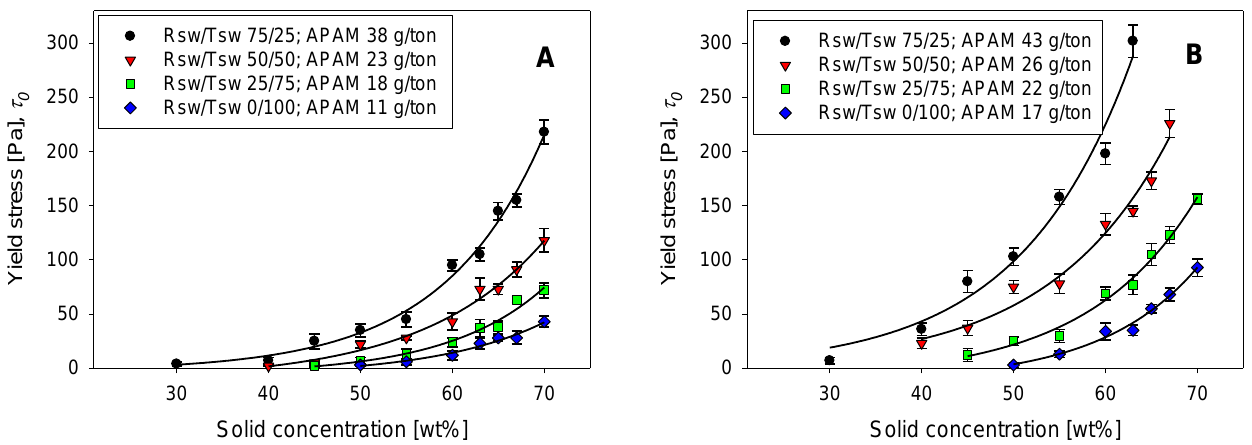
Figure 10. Yield stress of clay-based synthetic tailings flocculated in a range of solid concentrations, using raw seawater (Rsw) and treated seawater (Tsw) at different proportions. ( A ): Tailings 1 with quartz/kaolin at 90/10 ratio; ( B ): Tailings 2 with quartz/kaolin at a 75/25